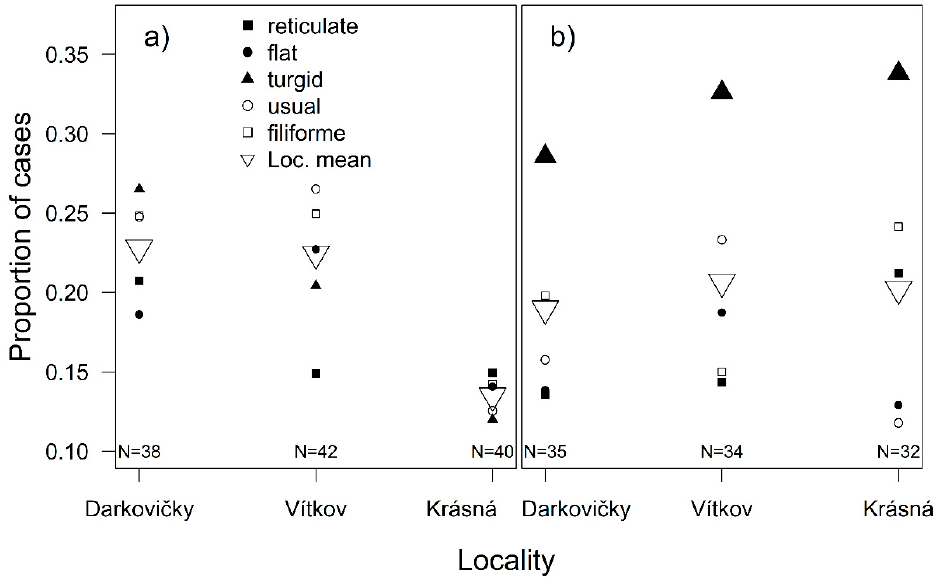
Figure 2. Proportion of cases when beetles chose a particular morphotype ( reticulate, flat, turgid, usual, filiforme ) of moss sampled from individual localities (Loc. mean = mean proportion of cases when beetles chose the mosses sampled from the locality), when the mosses had ( a ) preserved spatial structures or ( b ) removed spatial structures. The differences in proportion of cases when beetles chose a morphotype from individual localities were tested by generalized estimating equation models with binomial distribution. “N” denotes the number of beetles encountering a morphotype from a given locality.